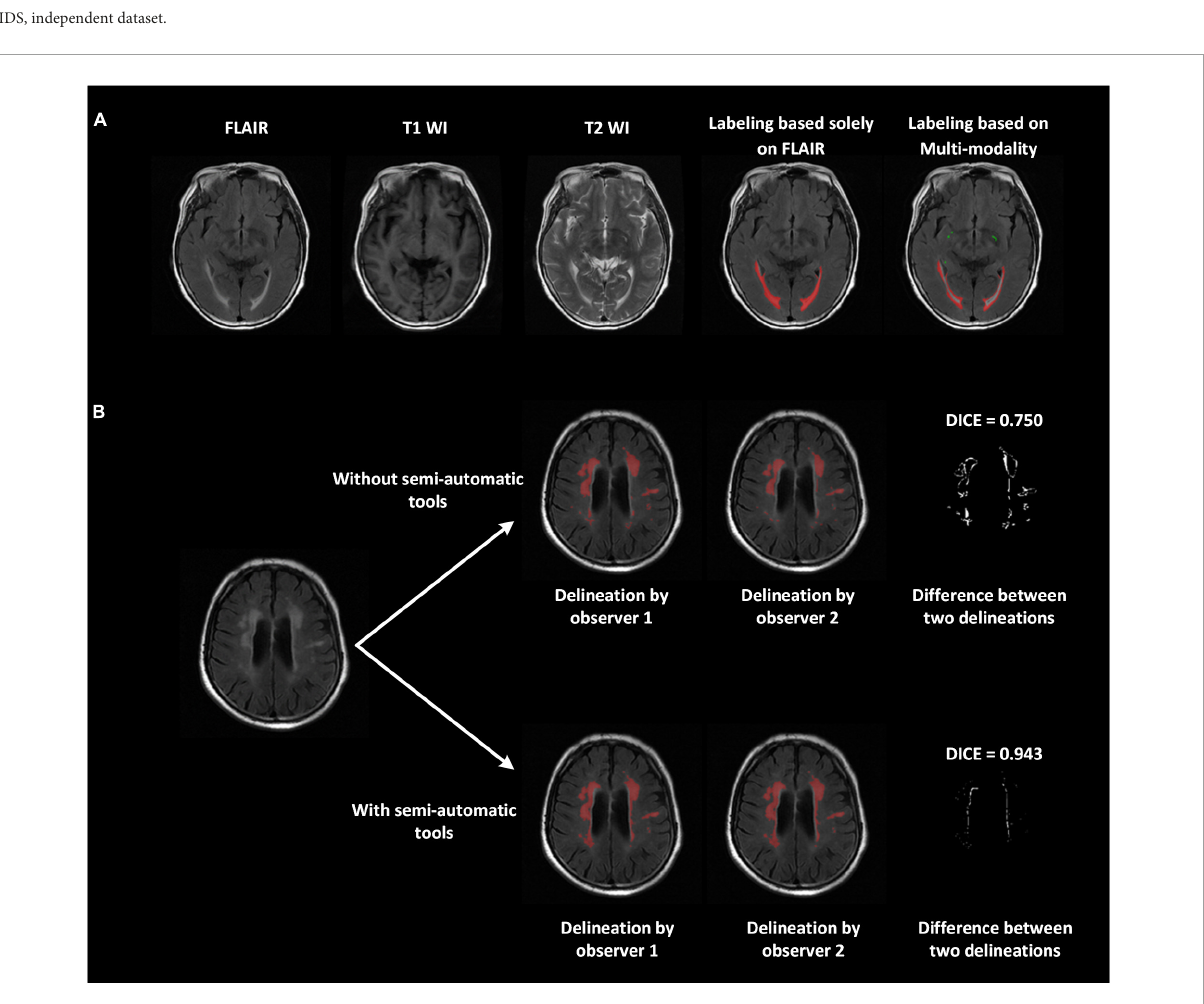
FIGURE2 Improved delineation with our labeling strategies. (A) Multi-modality images (T1-weighted, T2-weighted, and FLAIR) applied to differentiate WMH and other intracranial lesions and reduce false positives. The ventricular regions were correctly avoided. The perivascular space, marked in green, was also labeled jointly on all three modalities. (B) With the use of semi-automatic tools, the difference between the two delineations declined, and the Dice improved from 0.75 to 0.943.